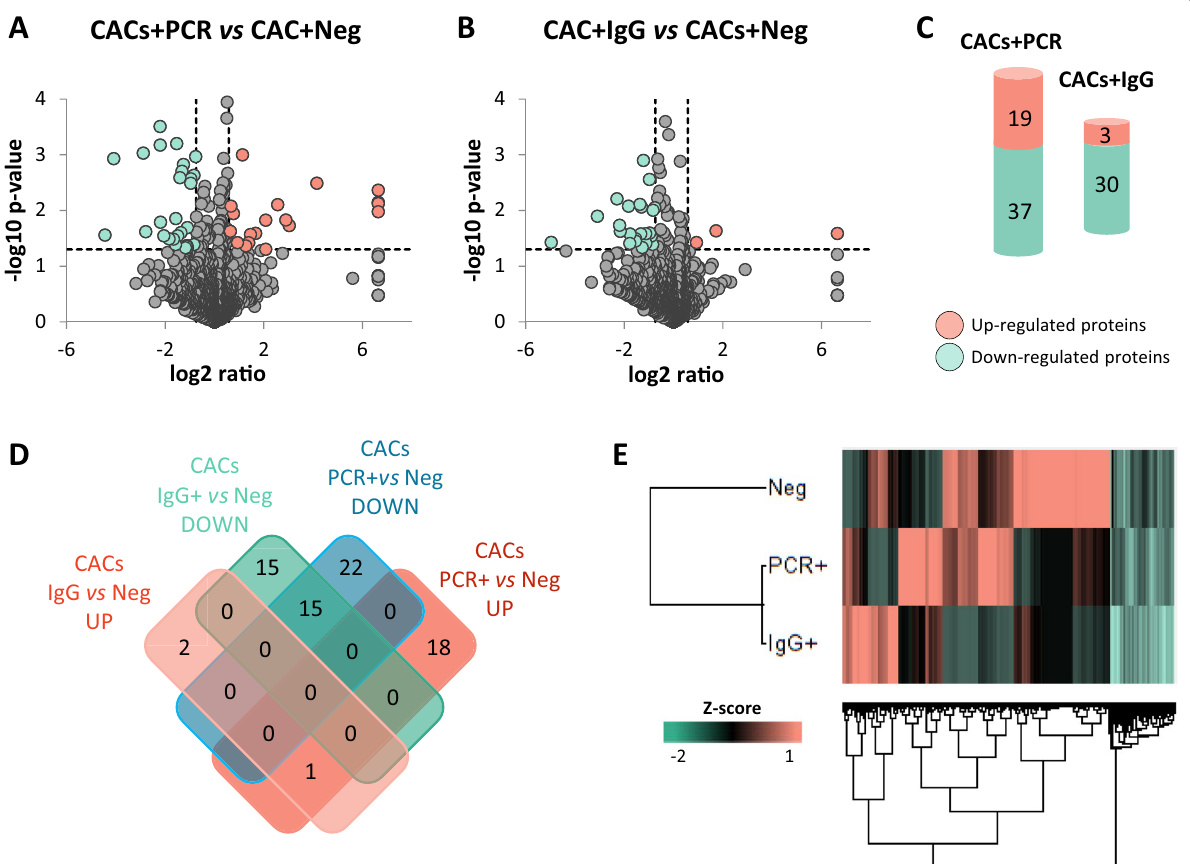
Fig. 3 Proteomic changes in CACs in response to the serum of COVID‑19 asymptomatic patients. Volcano plots representing proteins up‑ (red) or down‑ (green) regulated between CACs treated with A the serum of COVID‑19 PCR vs Negative donors (CACs PCR), or B the serum of + + IgG (CACs IgG) vs COVID‑19 negative donors (CACs Neg). C Schematic representation of the number of proteins up‑ (red) or down‑ regulated + + + (green) in CACs PCR or CACs IgG compared to CACs Neg controls. D Venn’s diagram including the number of proteins up‑ or down‑regulated, + + + common or exclusive in